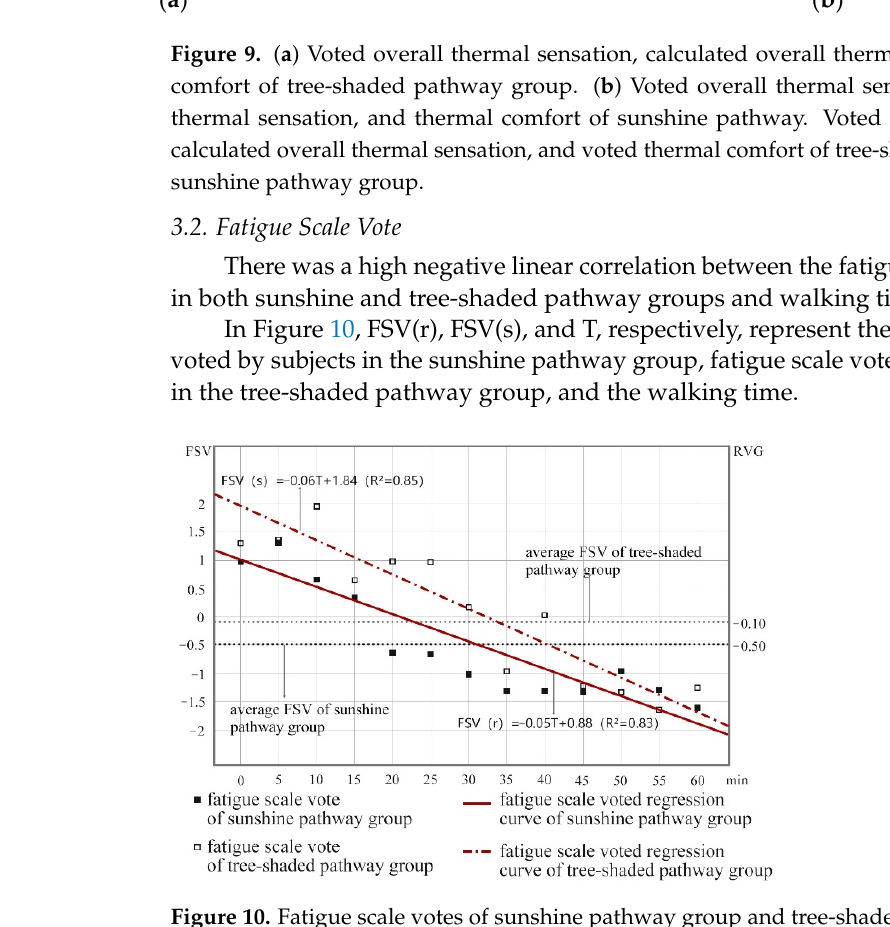
30 min of the experiment in the tree-shaded pathway group but then began to feel tired. The average fatigue scale vote value for the whole process was −